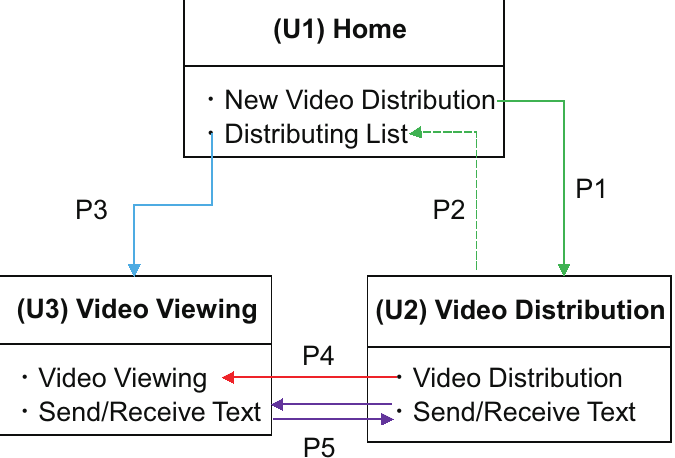
Figure 7. Overview of Web screen transitions in the proposed